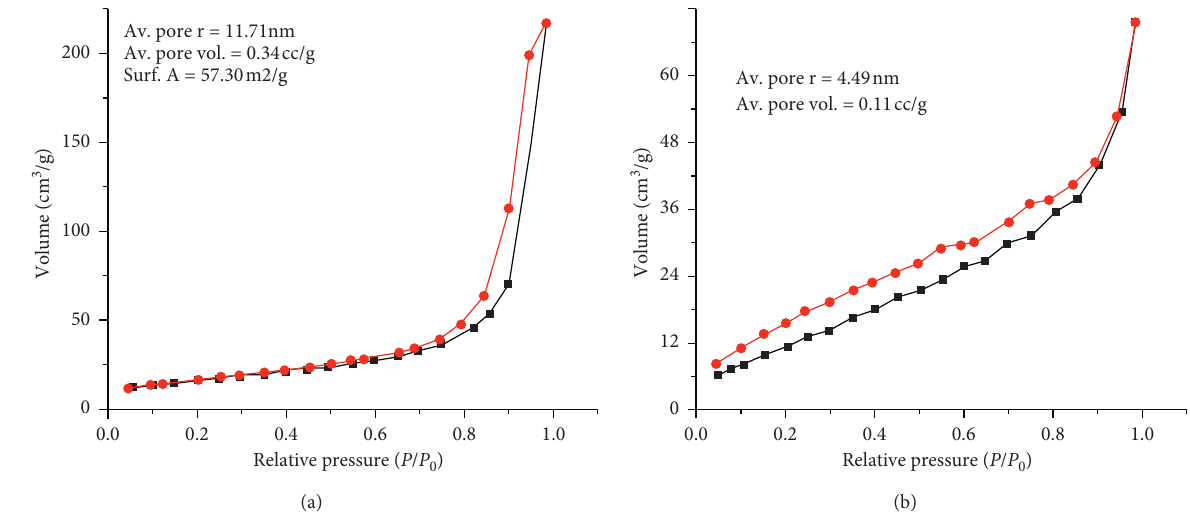
Figure 8: BET isotherms and BJH information of (a) LEuH-Cl aggregates and (b) LEuH-flocs